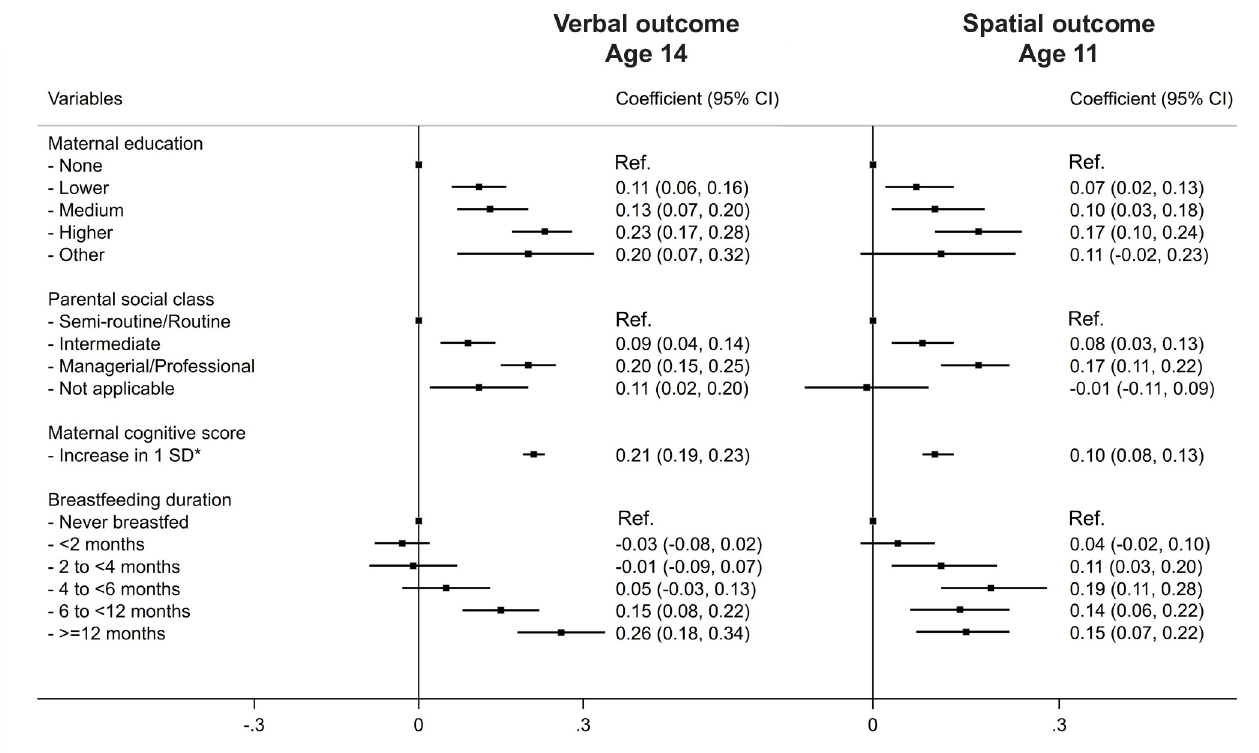
Fig 6. Comparison of the coefficients for breastfeeding duration, markers of socioeconomic position and maternal cognitive scores on verbal and spatial cognitive outcomes � at ages 14 and 11, respectively. The models adjusted for all potential confounders of the association between breastfeeding duration and cognitive scores, and include an interaction between breastfeeding duration and age of outcome measurement. � Standardised maternal cognitive scores (Mean: 0; SD: 1).